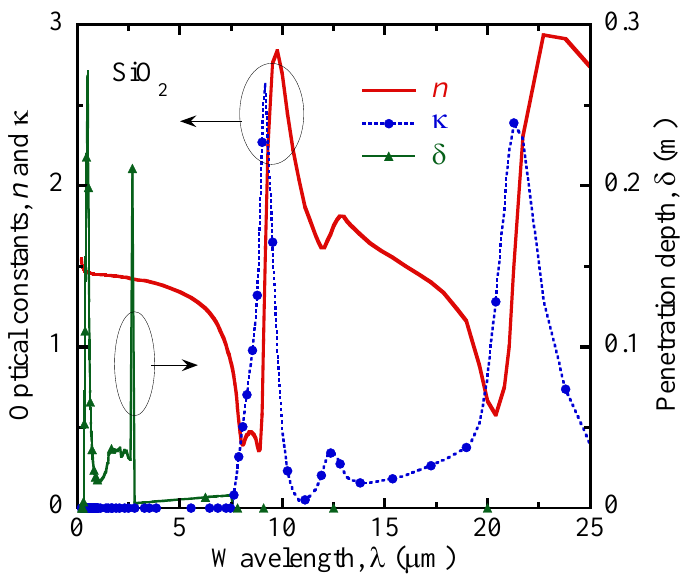
Figure 2. Optical constants ( n and κ) of glass (SiO 2 ) and the penetration depth ( δ ) of a 0.7-mm-thick glass panel at the spectral range 0.2 µ m ≤ λ ≤ 25 µ